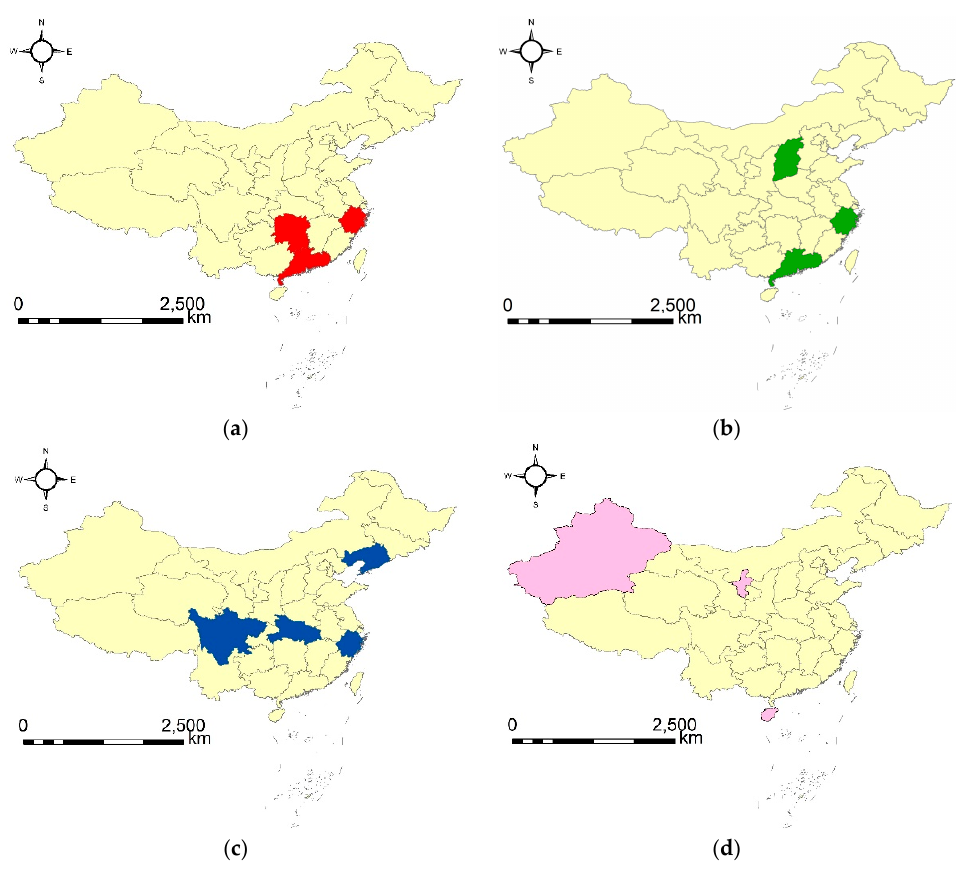
Figure 5. The discovered geographical flock patterns: ( a ) {11, 18, 19}|[2012, 2014] (type B), ( b ) {4, 11, 19}|[2013, 2015] (type B), ( c ) {6, 11, 17, 23}|[2014, 2016] (type B), and ( d ) {21, 29, 30}|[2002, 2004] (type C).